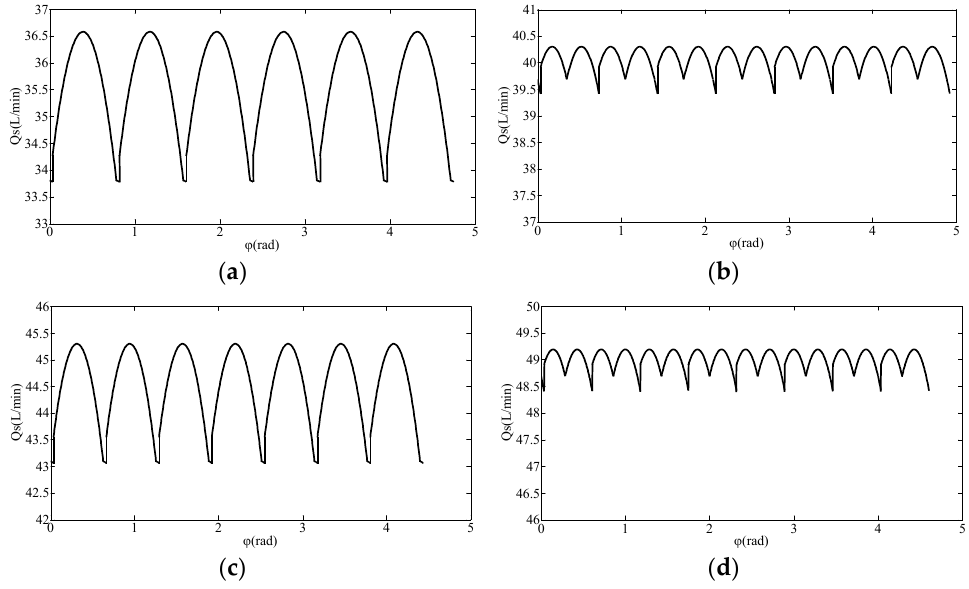
Figure 11. Actual output flow rate of piston pumps with 8~11 pistons for Δ φ /2 = φ 0 = 1°. ( a ) output